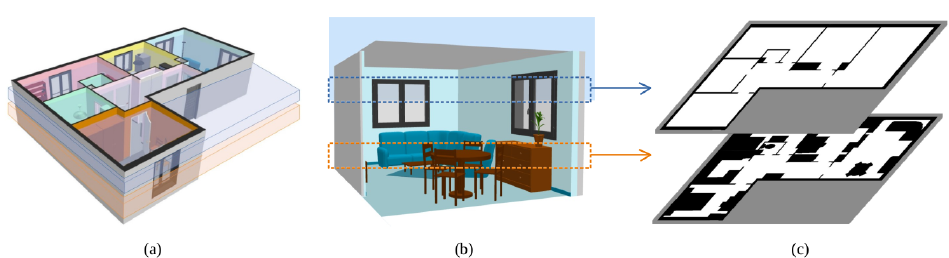
Figure 3. The 3D slices for 2D mapping: ( a ) initial scenario, where the slices are marked in blue (layout space) and orange (navigation space), ( b ) location of the 3D slices inside a room, where the layout space is empty and the navigation space contains furniture, and ( c ) resulting 2D occupancy grid maps.